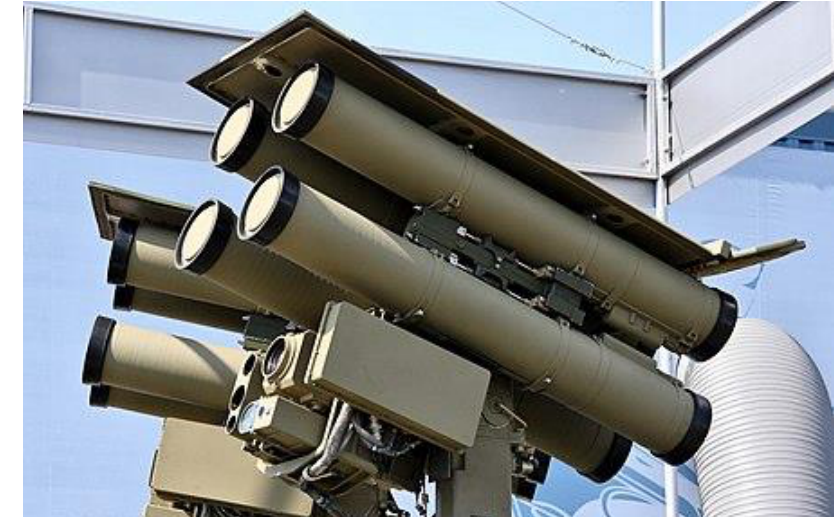
Рис. 3 – ПТУР 9М133М «КОРНЕТ-М» на платформе «КОРНЕТ Д» Слика 3 – ПОВР 9М133М „КОРНЕТ – М” на „КОРНЕТ Д”